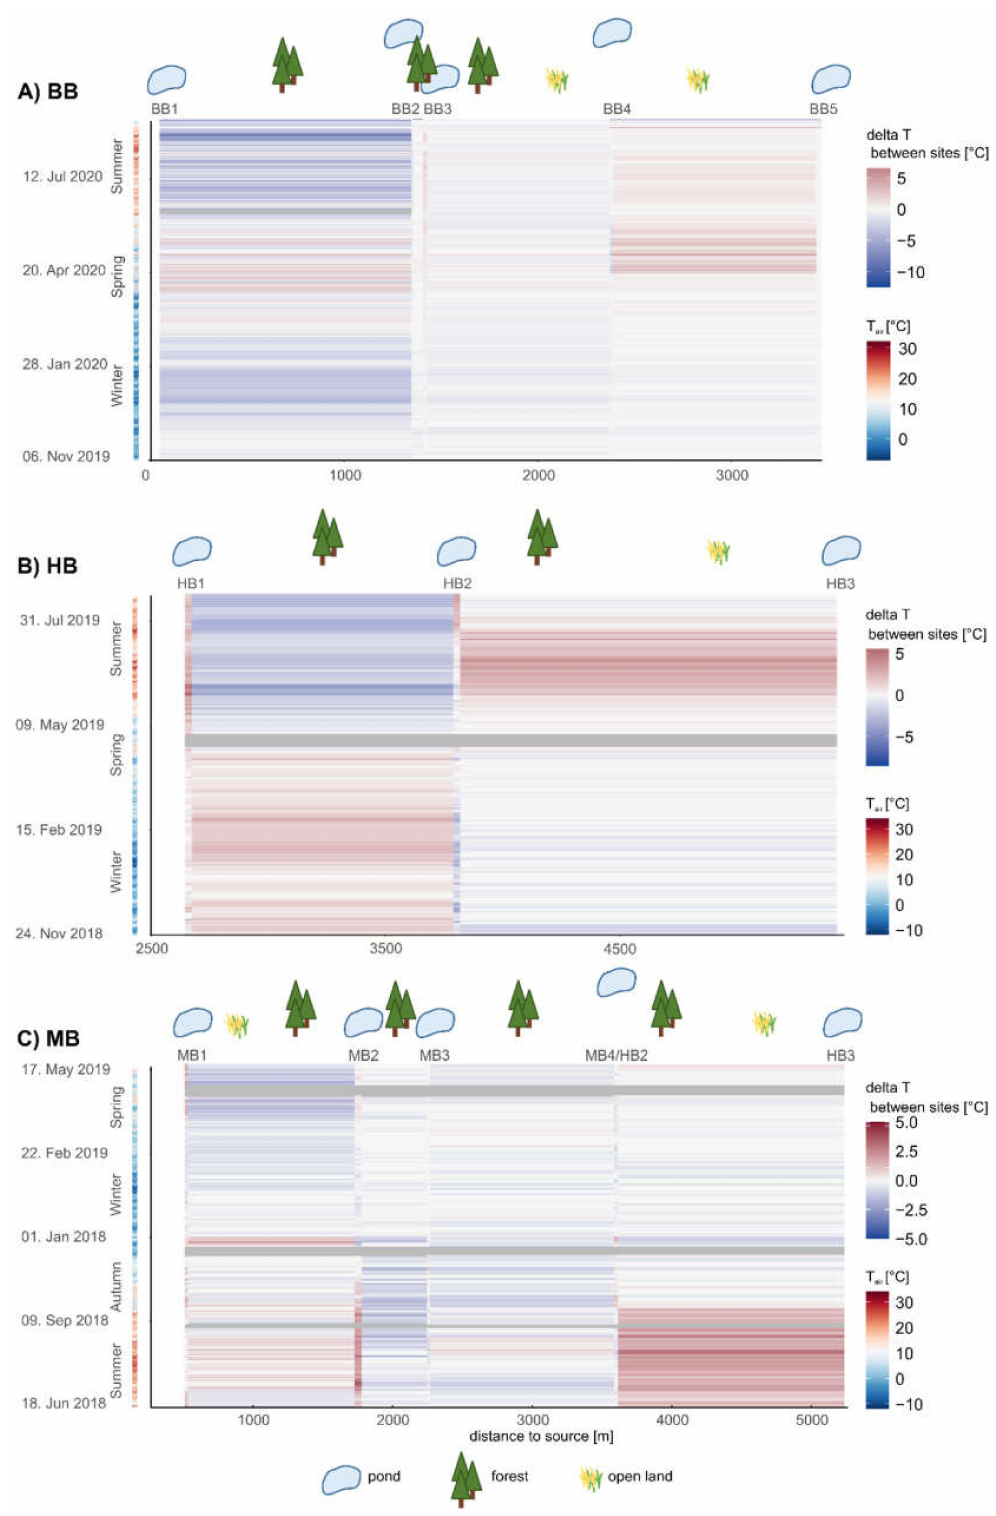
Figure 5. Temperature difference between two subsequent monitoring points (point X–point X + 1) along the three study streams; within a sampling site (this refers to the reach between us and ds monitoring points) and between sampling sites (this refers to the reach between ds point of the upstream and us point of the subsequent site); Line color gives the difference in water temperature; matching air temperature at the climate station “Hof” is represented on the left side; pictograms represent the main LU features along the respective